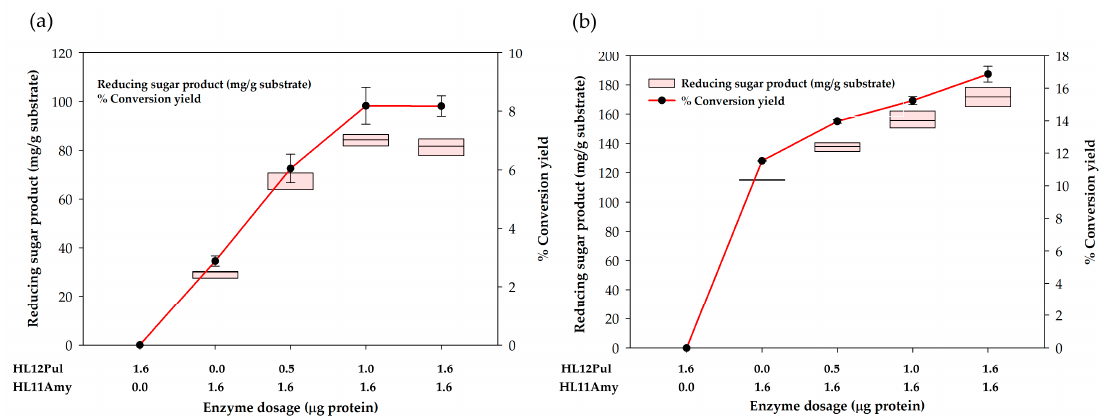
Figure 5. The evaluation of the synergistic interaction of type I pullulanase HL12Pul with RSD α -amylase HL11Amy. Varying enzyme loading of HL12Pul was added into a raw starch hydrolysis reaction. The reactions were incubated at 40 ◦ C for ( a ) 30 min and ( b ) 60 min.